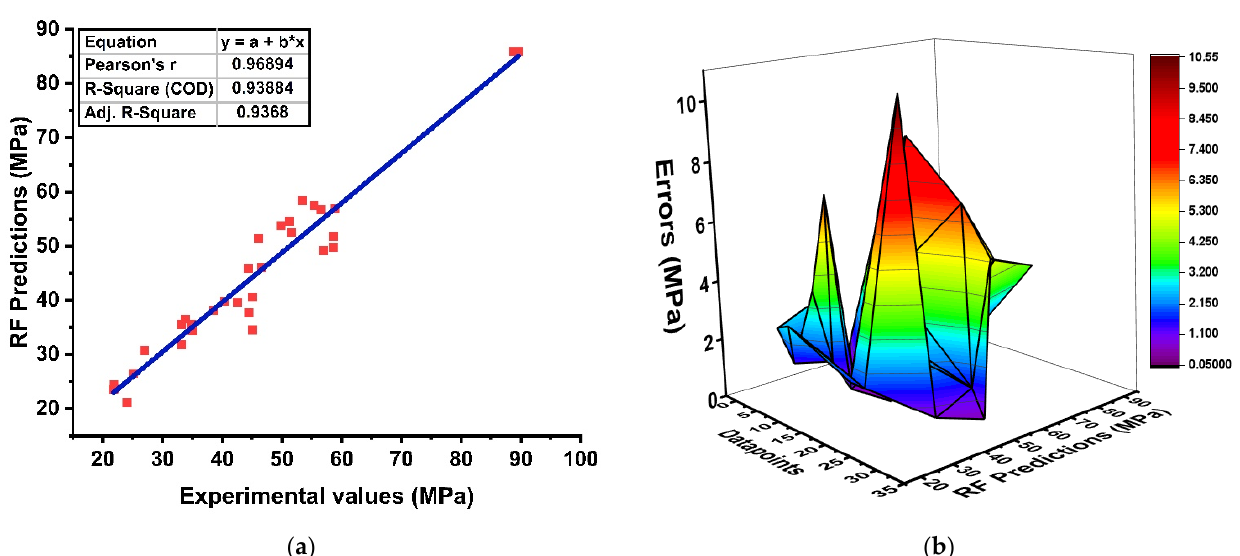
Figure 7. RF; ( a ) Relationship of experimental and predicted values; ( b ) Error-distribution result of model.